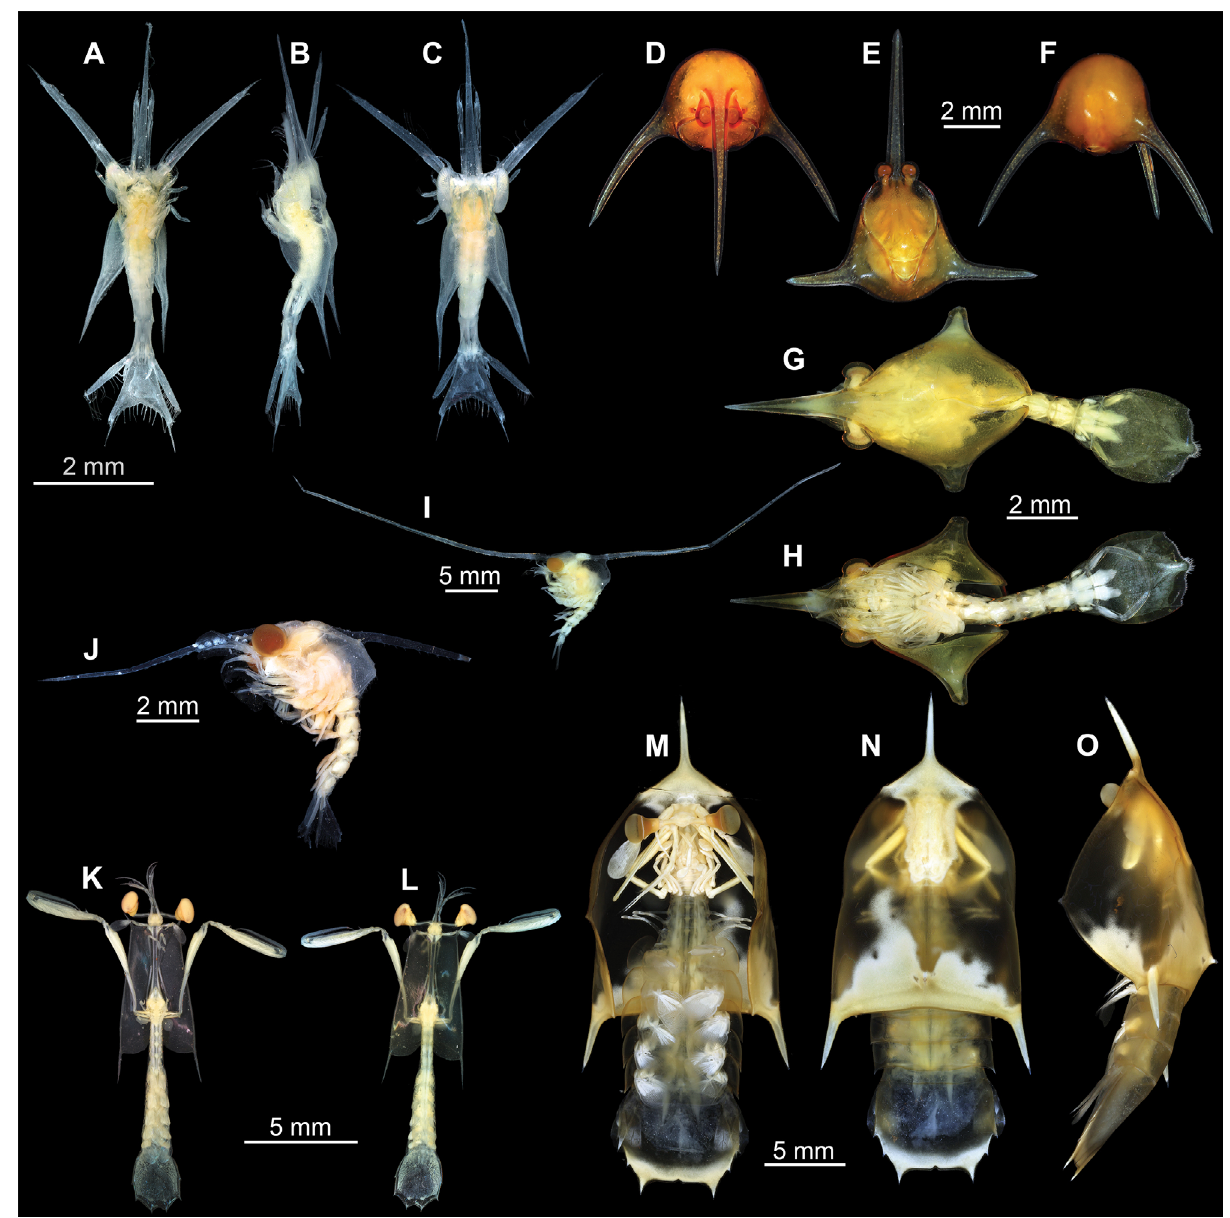
Figure 1. Comparison of unidentified larvae of the four groups of Eumalacostraca, museum specimens under cross-polarized light. A–C: Representative of Galatheidae, specimen MNHN-IU-2014-5513B. A. Ventral view. B. Lateral view. C. Dorsal view. D–F: Representative of Hippoidea, specimen MNHN-IU-2014-5468 (after Rudolf et al., 2016). D. Anterior view. E. Ventral view. F. Posterior view. G–H: Representative of Hippoidea, specimen NMHD-86486 (Old number: ZMUC-CRU-8682; after Rudolf et al., 2016). G. Dorsal view. H. Ventral view. I: Representative of Raninidae, specimen MNHN-IU-2014-5467, lateral view. J: Representative of Raninidae, specimen MNHN-IU-2014-5360, lateral view. K–L: Representative of Stomatopoda, specimen NHMD-916095 (Old number: Stat-3955-II-A). K. Ventral view. L. Dorsal view. M–O: Representative of Stomatopoda, specimen ZMUC-CRU-8660 (after Haug et al., 2016). M. Ventral view. N. Dorsal view. O. Lateral